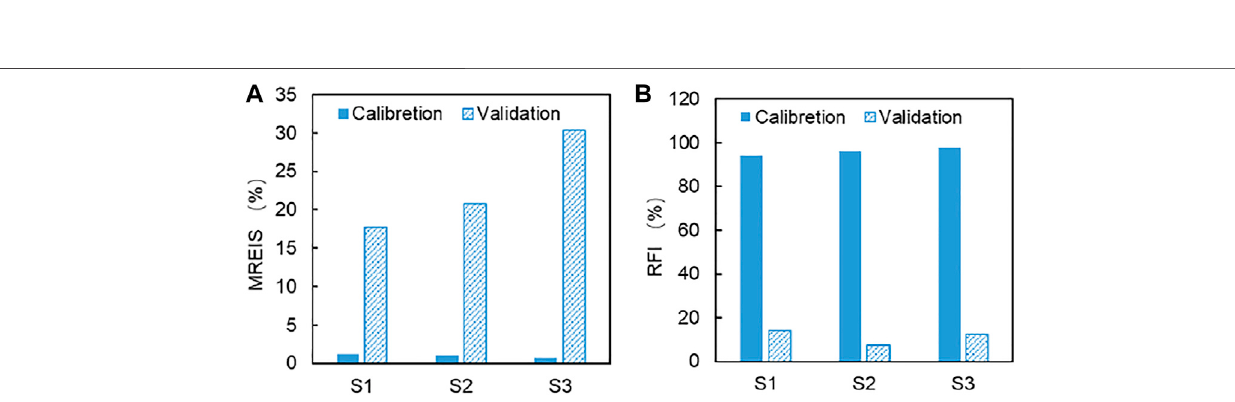
Frontiers in Earth Science |